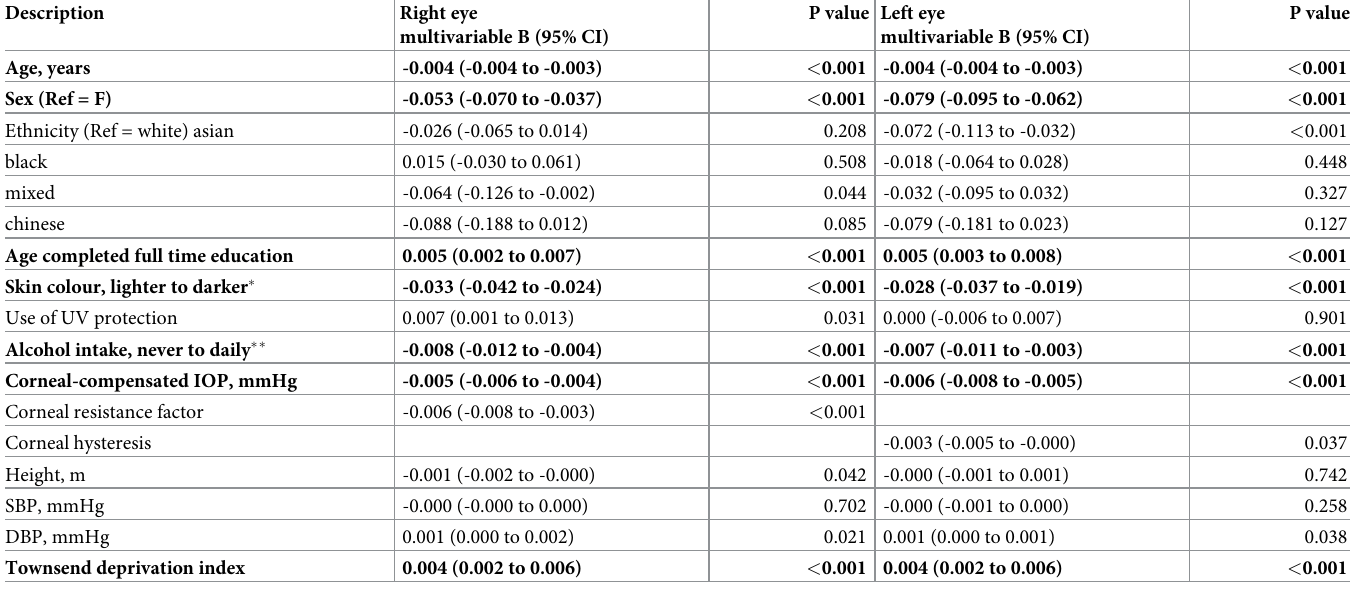
Table 4. Results of multivariable regression in 83,751 study participants in the UKBB for right and left eye corneal astigmatism. Only parameters that were signifi- cant in the univariable regression were included in the multivariable regression. Significant associations are highlighted in bold. P values for B coefficients are derived from a t-test. 95% CI = 95% confidence